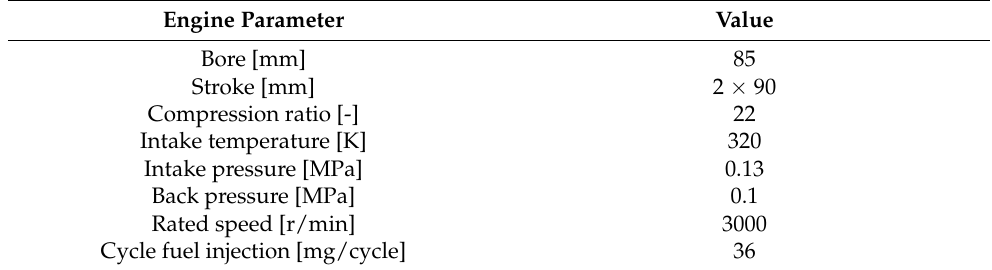
Table 1. Specifications of the OP2S diesel engine [17].